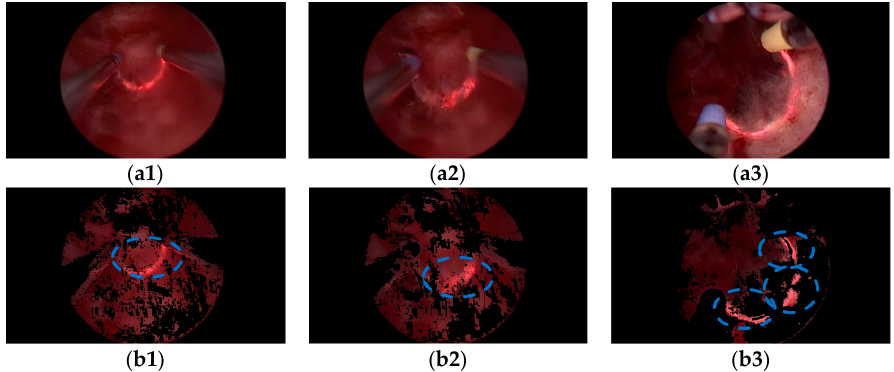
Figure 4. ( a1 – a3 ) Original images that consist of the blood and red light. ( b1 – b3 ) Image processing results using the hue, saturation, and value (HSV) color space analysis method.